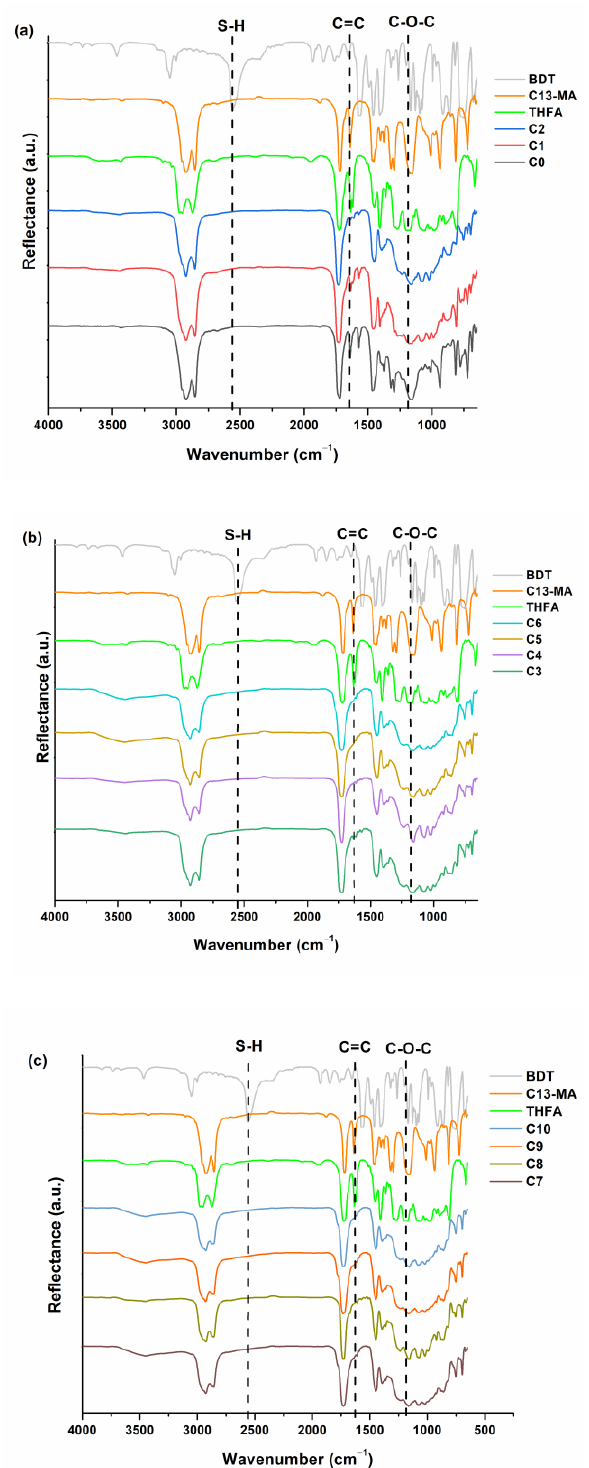
Figure 4. FT-IR spectra of THFM, C-13MA, BDT, and photopolymers C0 – C2 ( a ), C3 – C6 ( b ), C7 – C10 ( c ). Polymer samples C0 – C2 were not further studied as they were too soft. The yield of the insoluble fraction of photopolymers C3 – C10 was in the range of 55– 83% (Table 3) and increased with increasing THFA content up to sample C9 (83%), while